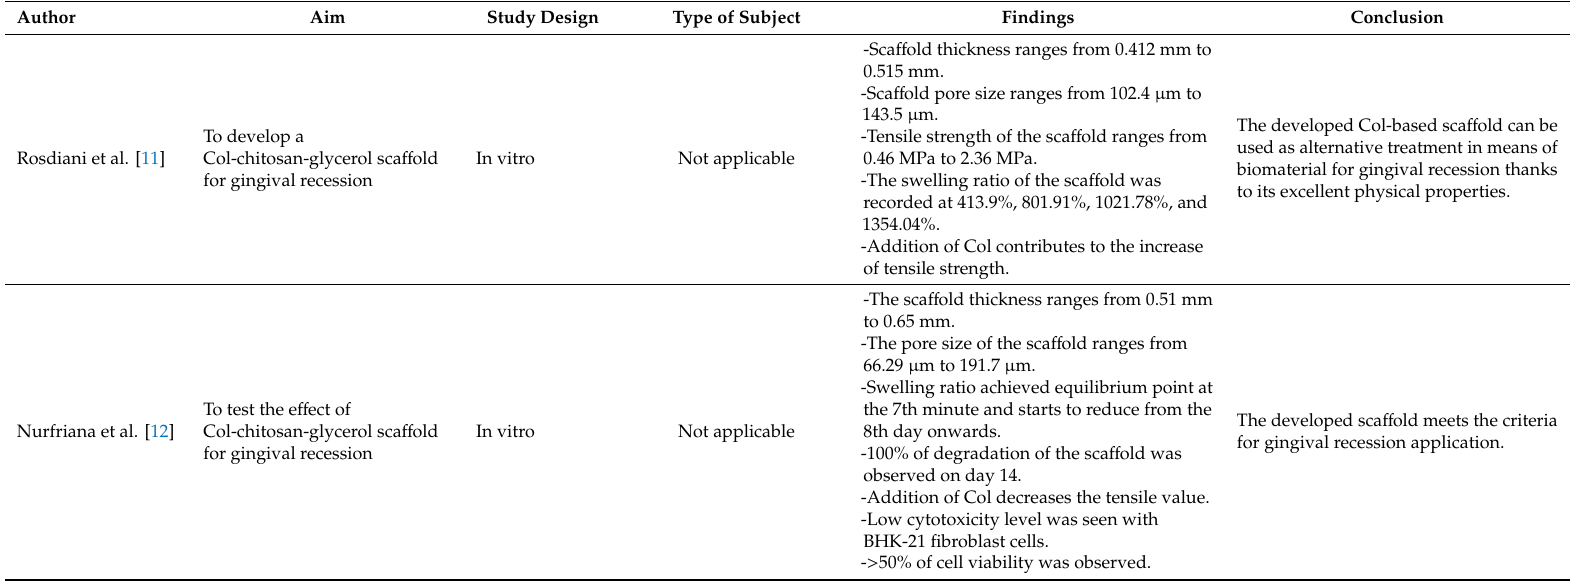
Table 1. Cellulose-biosca ff old